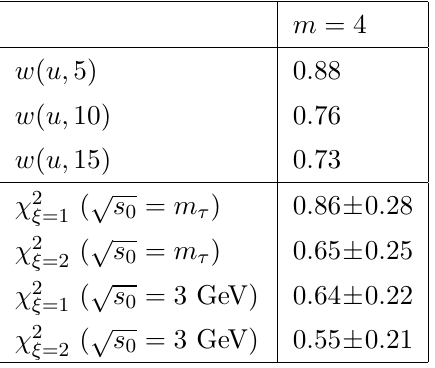
Table 5 . Results for N g for the n f = 0 flavor scheme at O ( α 4 approach (upper part) as well as the optimal subtraction approach (lower